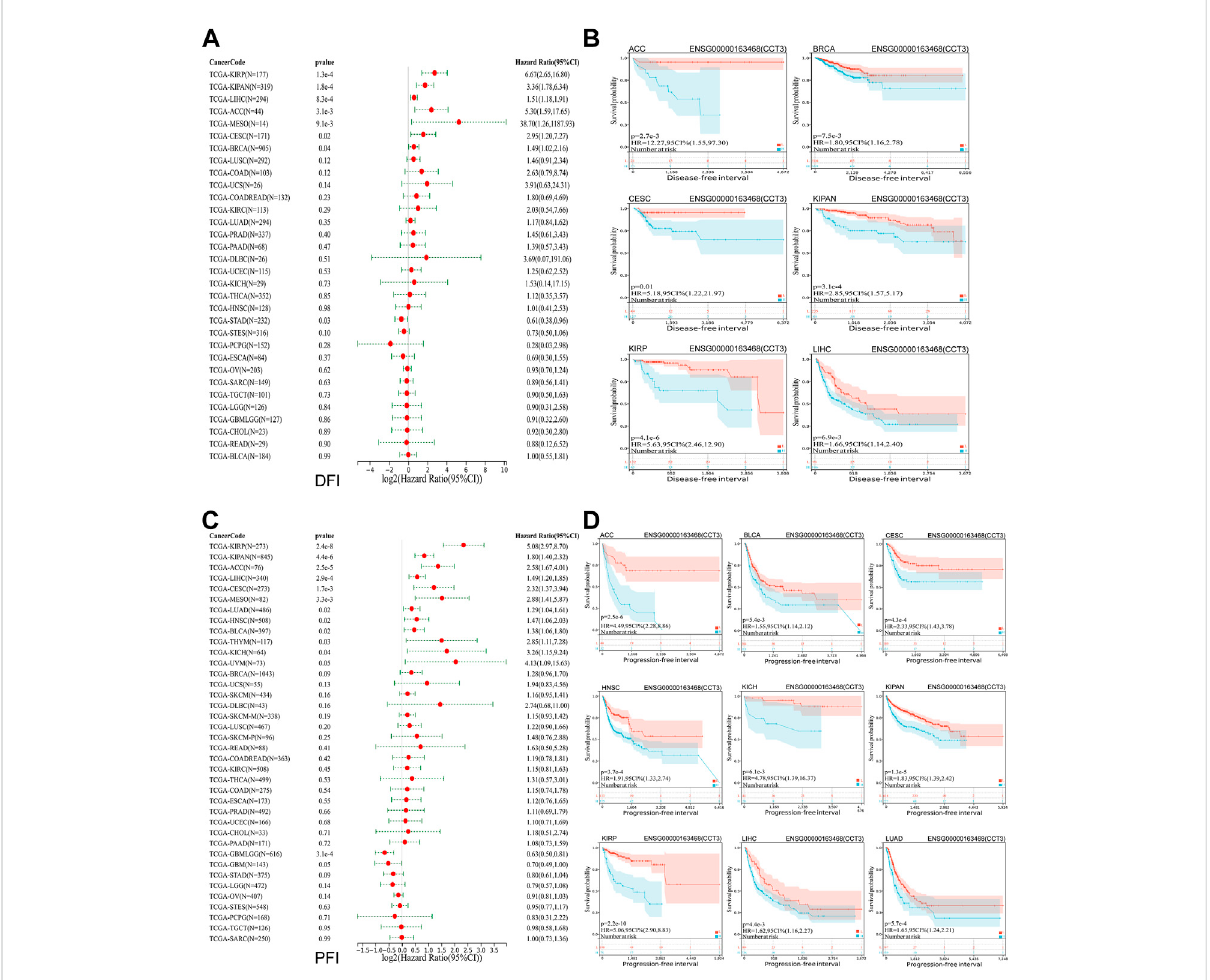
FIGURE 4 Prognostic value of CCT3 for disease-free interval (DFI) and progression-free interval (PFI) in pan-cancer. (A) Forest plots showed the correlation between CCT3 expression and DFI in 33 cancer types. (B) The KM curves showed the correlation between CCT3 expression and DFI in pan-cancer. (C) ForestplotsshowedthecorrelationbetweenCCT3expressionandPFIin33cancertypes. (D) TheKMcurvesshowedthecorrelation between CCT3 expression and PFI in